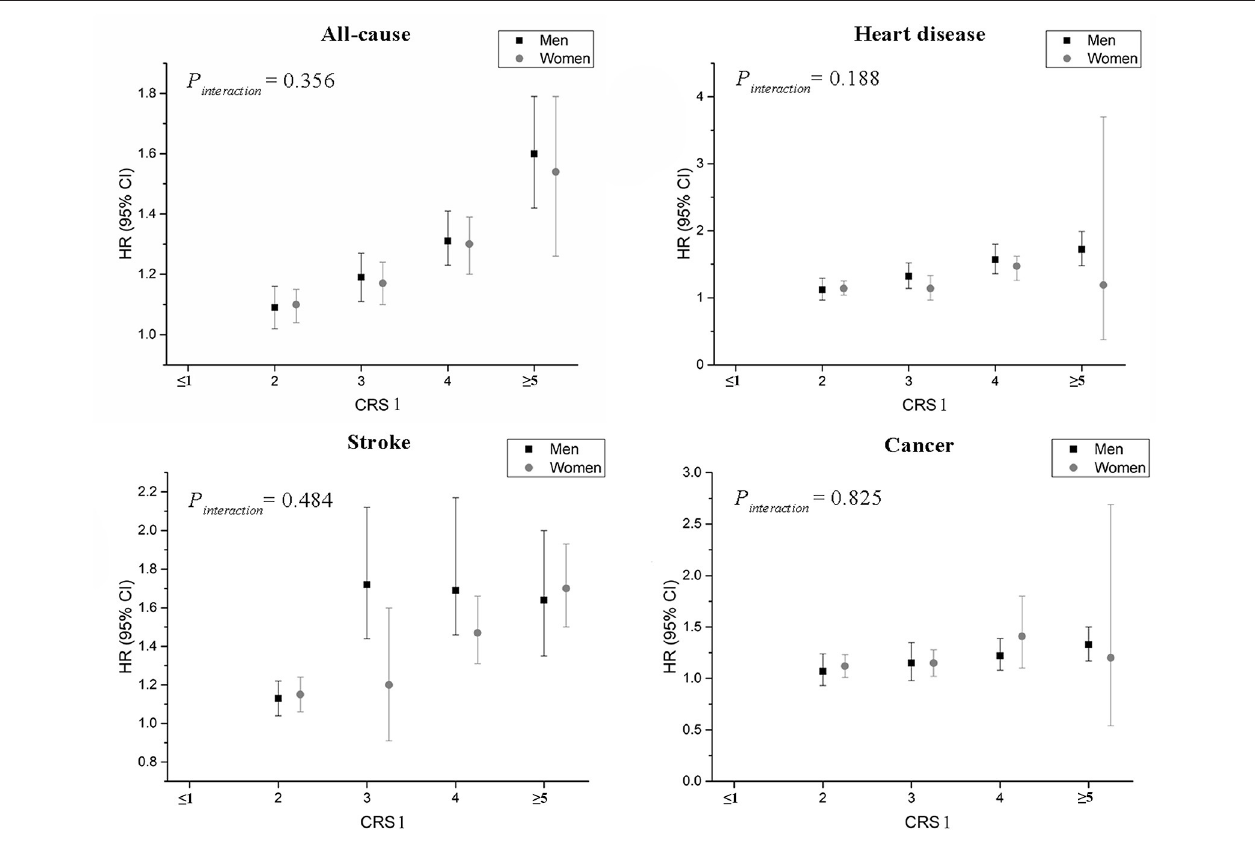
FIGURE 2 | Hazard ratios and 95% confidence intervals for the associations between CRS1 and risk of all-cause and cause-specific mortality by men and women in the Linxian Nutrition Intervention Trial Cohort. Multivariable hazard ratios were adjusted for age at baseline, commune, education level, and family history of cancer. CRS, combined risk